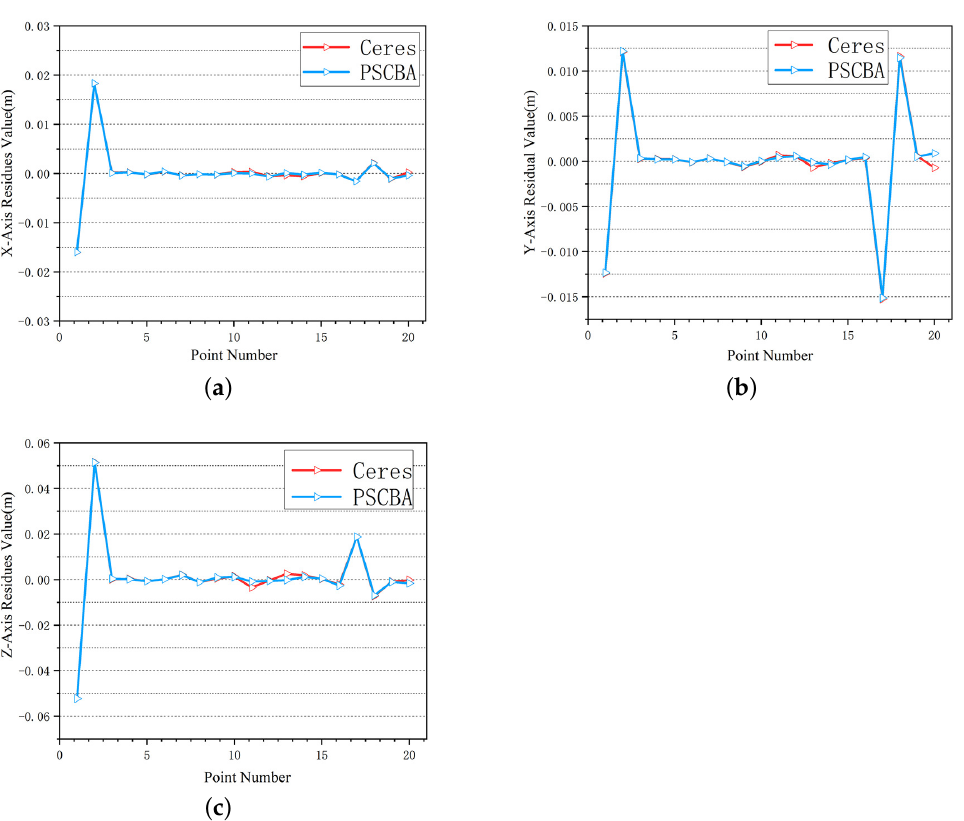
Figure 16. Each residual plot in the X, Y, and Z directions for dataset 1: ( a ) the residual plot in the X direction; ( b ) the residual plot in the Y direction; ( c ) the residual plot in the Z direction.